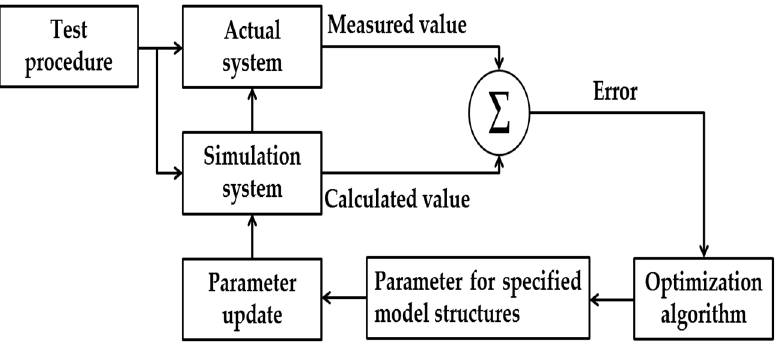
Figure 10. Measurement-based approach load modeling algorithm.